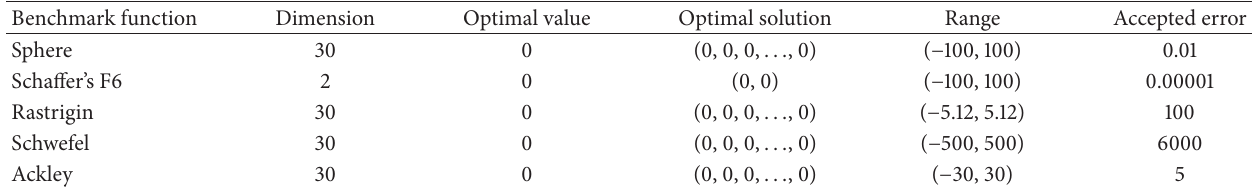
Table 2: Settings of benchmark